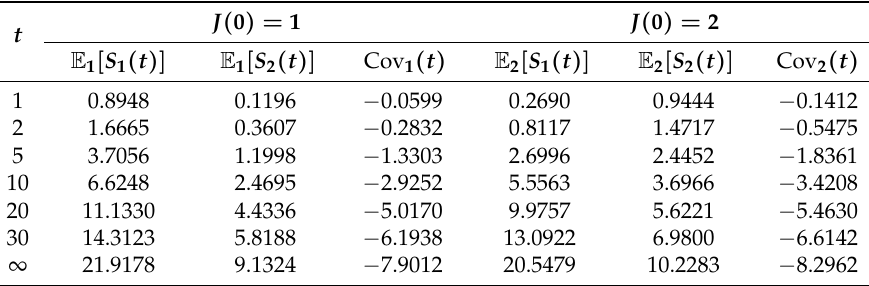
Table 1. Expected values and covariances of S 1 ( t ) and S 2 ( t )